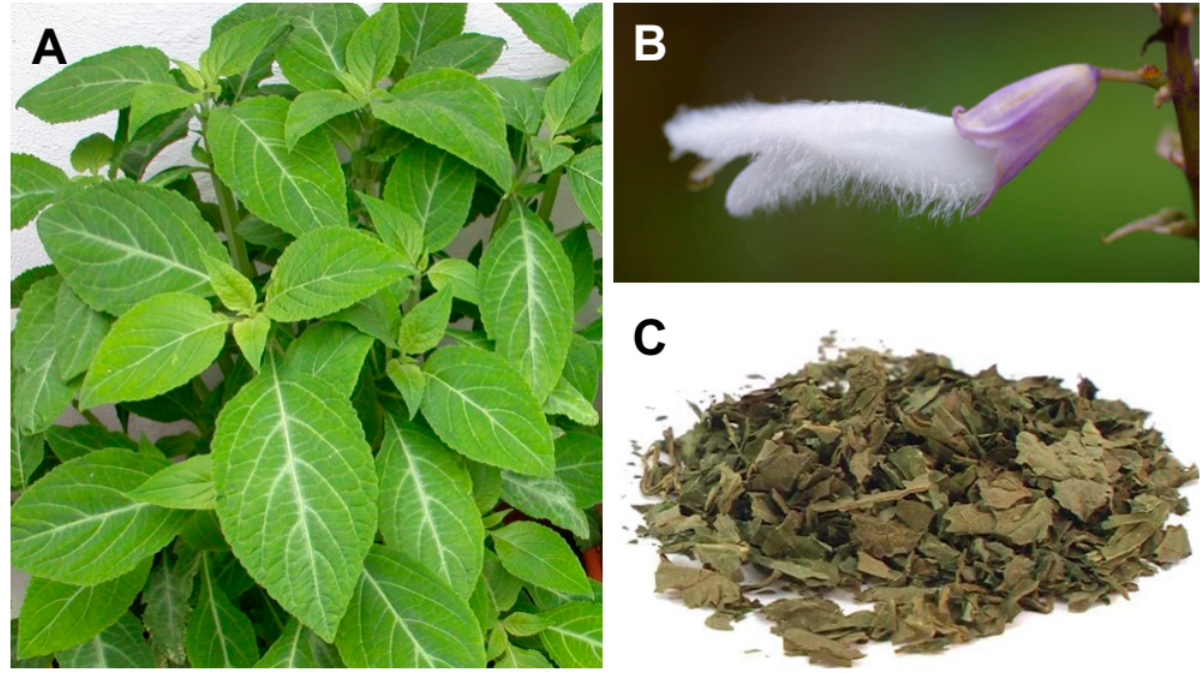
Figure 1. Salvia divinorum plant ( A ), the characteristic flower ( B ), and dry leaves ( C